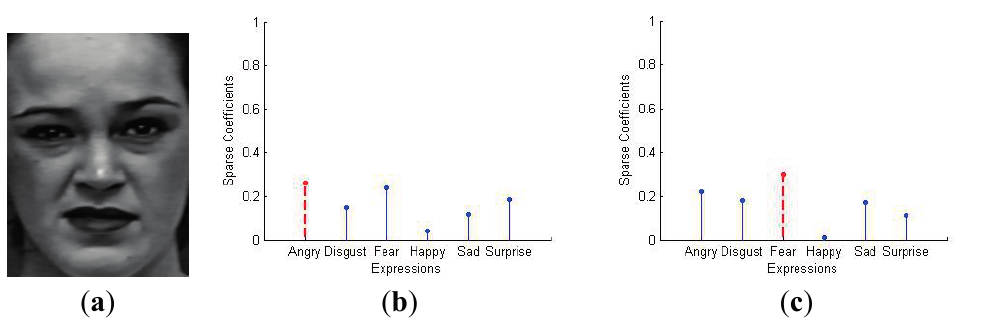
Figure 6. Recognition result of “Fear” with SR and MLSR. ( a ) “Fear” in low intensity; ( b ) Recognition result with SR; ( c ) Recognition result with